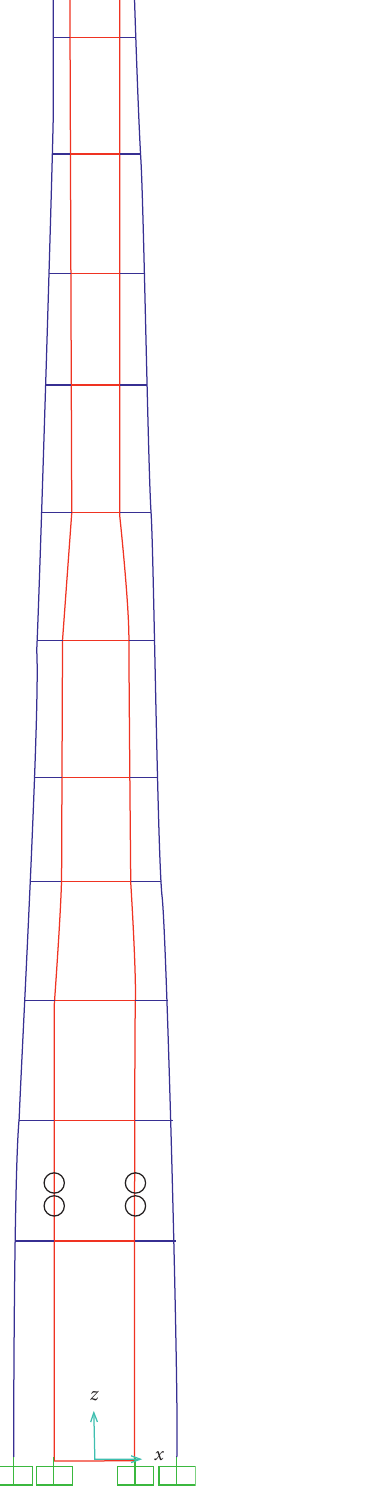
larger. The stiffness reduction factor relative to the prototype model is the ratio of the story displacement of the two models under the same static load. The simplified model has